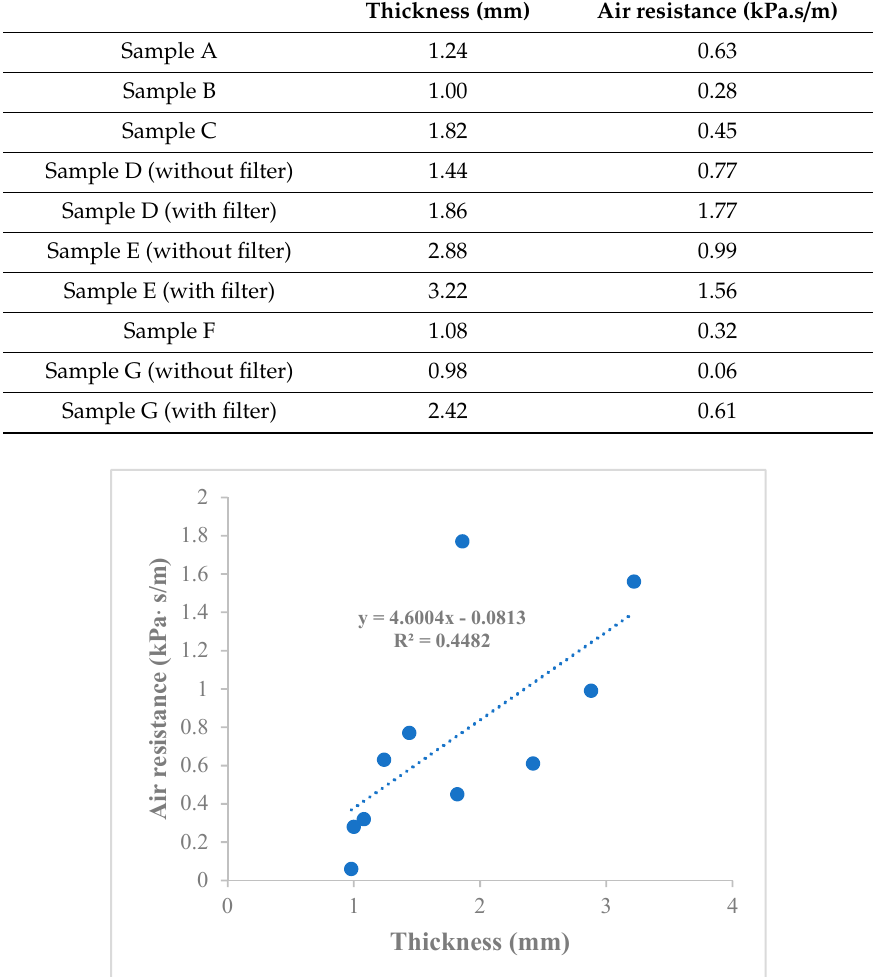
Figure 2. Correlation between thickness and air resistance of mask.